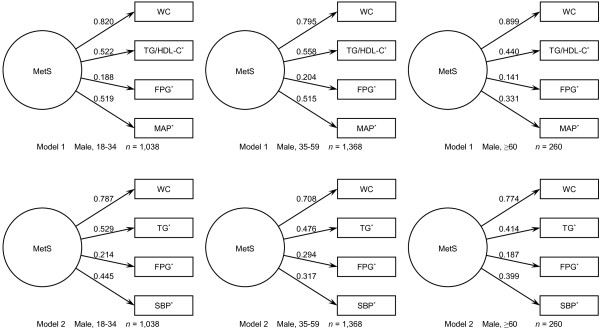
Two single-factor models for MetS for men in different age groups. Abbreviations: MetS, metabolic syndrome; WC, waist circumference; TG/HDL-C, the ratio between triglyceride and high-density lipoprotein cholesterol; FPG, fasting plasma glucose; MAP, mean arterial pressure; TG, triglyceride; SBP, systolic blood pressure. Models are grouped in different age ranges in both sexes. Values with asterisk (*) were loge transformed in CFA.